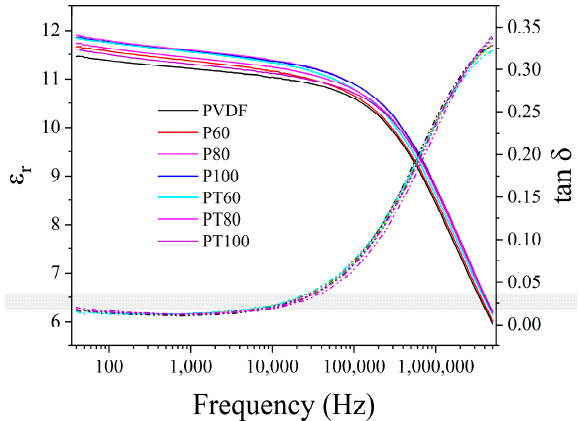
Figure 8. Dielectric constant and loss factor of PVDF and its composite.